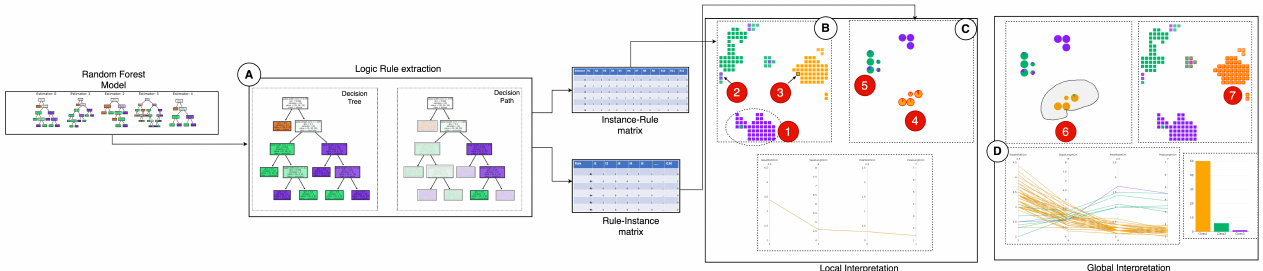
Figure 1. RFMap system with Iris dataset. The letters indicate the system’s different modules. ( A ) is the Logic rule extraction part, after which we derive the instance-rule and rule-instance matrices for our projections; ( B ) is the Instance View ; ( C ) is the Forest View ; ( D ) is the Feature View . The user first explores the Instance View and notices the three separated clusters of classes by color. One of the clusters (1) is shown in dotted circles. They take note of some misclassified instances (2) from the view. They then click on an instance (3) to understand the knowledge learned by the instance from the forest. The highlighted rules in (4) show the logic rules being used by the particular instance. The user analyzes the structural differences (similar or not similar rules) and certainty, coverage of the various logic rules as shown in (5). To understand a ‘knowledge cluster’, the user draws a lasso around the certain cluster of rules (6), and the instances covered by the rules are highlighted in (7). For enabling further interpretation and analysis, the knowledge contents are shown in ( D